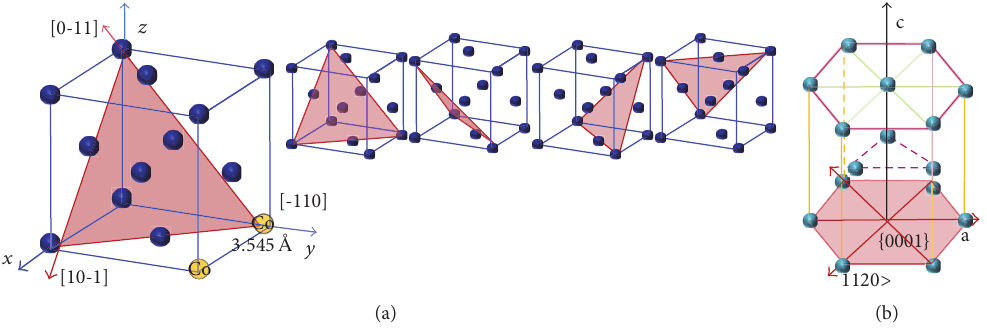
Figure 1: Crystalline structures and the slip system of cobalt: (a) cubic-Co and (b) hcp-Co.